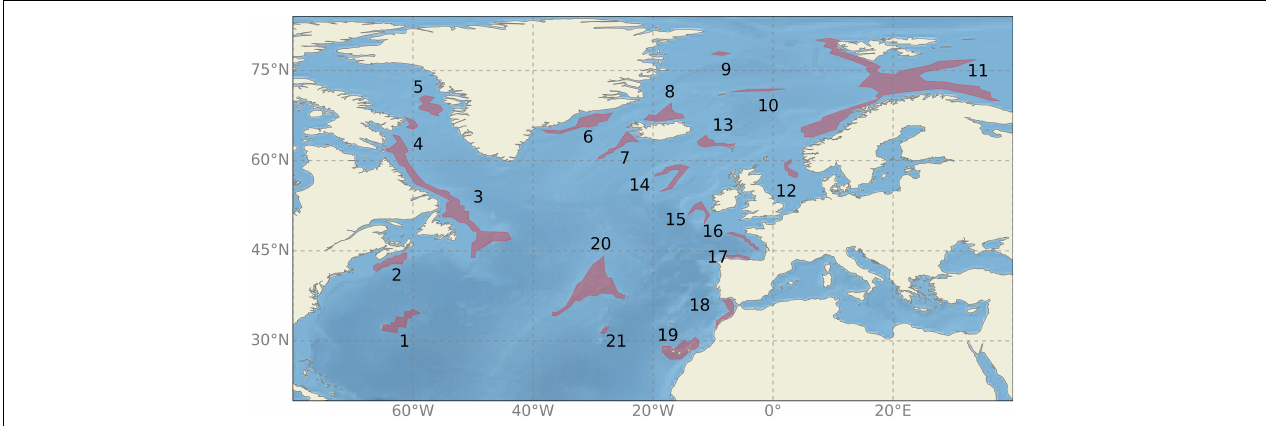
FIGURE 1 | Map of the North Atlantic Ocean including part of the Arctic Ocean showing the locations of the 21 sponge habitats studied in this paper. The habitats are ordered from 1 to 21, with the corresponding number marked on the